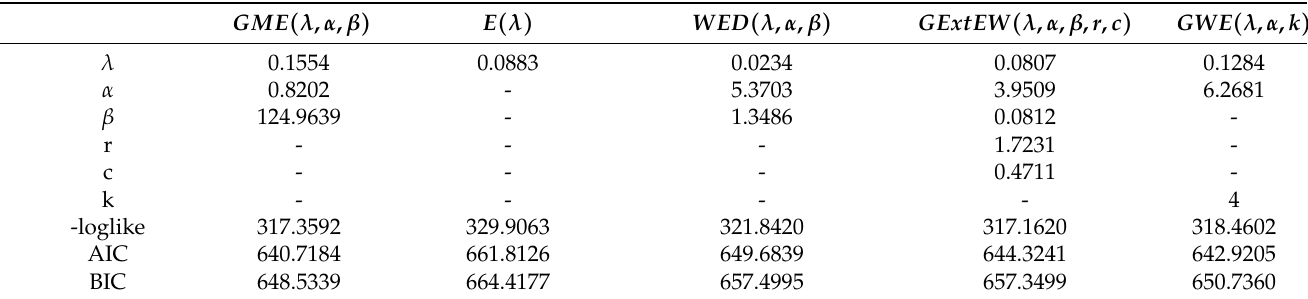
Table 4. Data set 1 : Comparison between the GME, E, WED, GExtEW, and GWE by using different criteria. GME ( λ , α , β ) E ( λ ) WED ( λ , α , β ) GExtEW ( λ , α , β , r , c